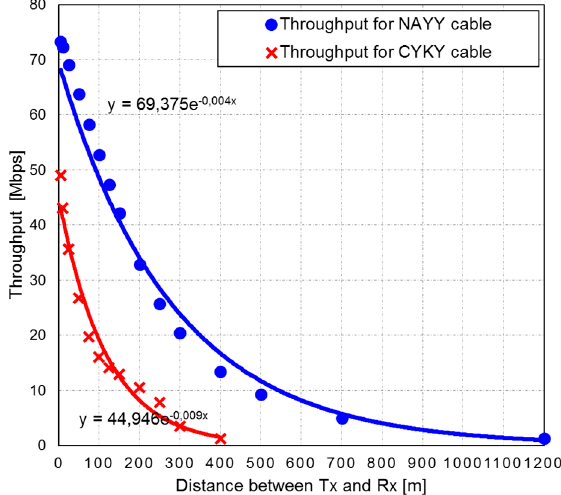
Figure 5. Channel capacity for NAYY150SE and CYKY 3 × 2.5 cable with varying length from transmitter to receiver.